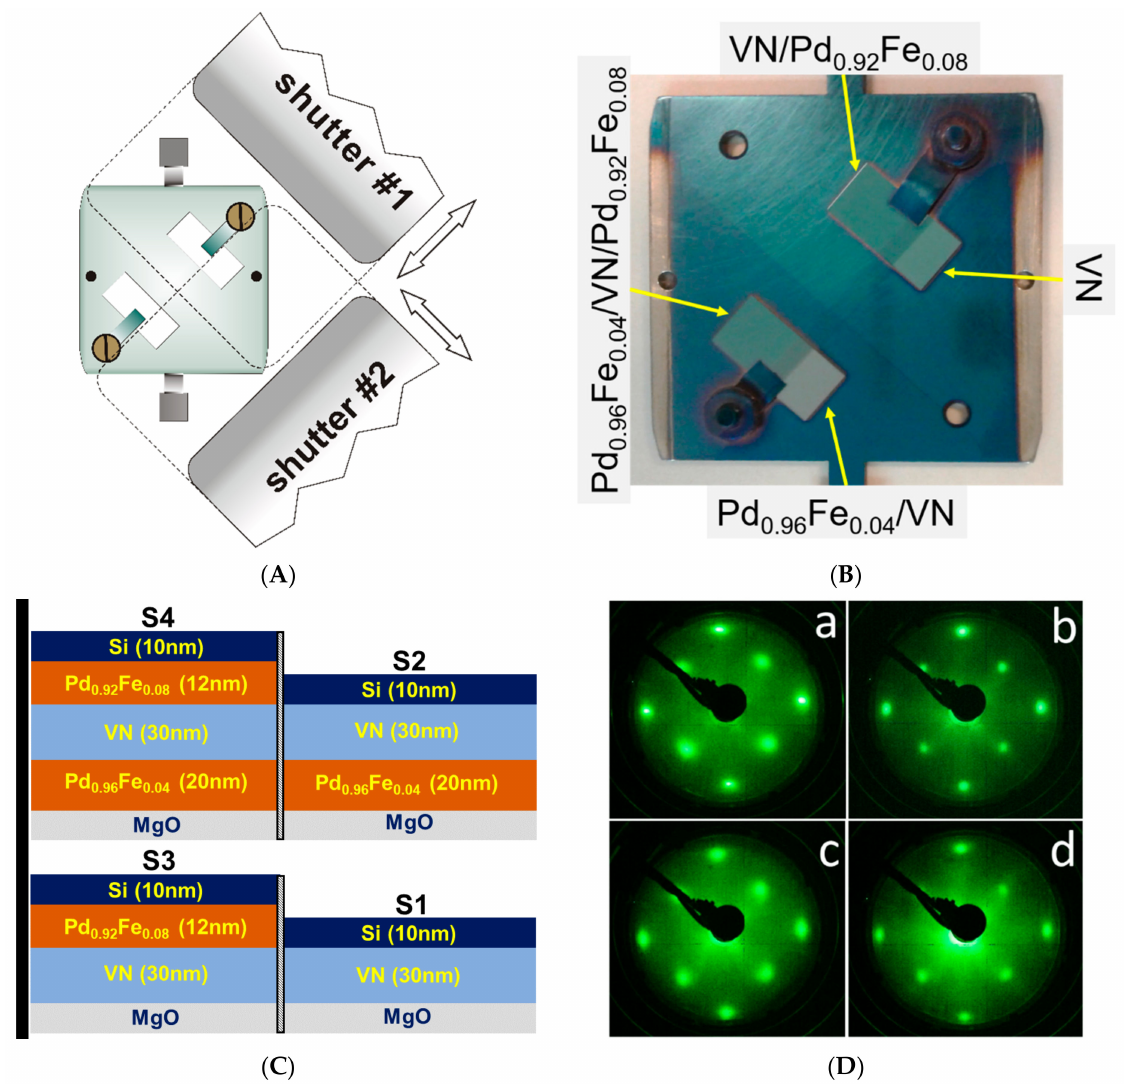
Figure 1. Deposition of the four-sample series in one run: ( A ) layout of the sample holder and shutters; ( B ) photo of the sample holder with the synthesized structures; ( C ) sketch of the sample’s structures; and ( D ) LEED patterns (a, pristine MgO substrate; b, MgO/Pd 0.96 Fe 0.04 structure; c, MgO/Pd 0.96 Fe 0.04 /VN structure; d, MgO/Pd 0.96 Fe 0.04 /VN/Pd 0.92 Fe 0.08